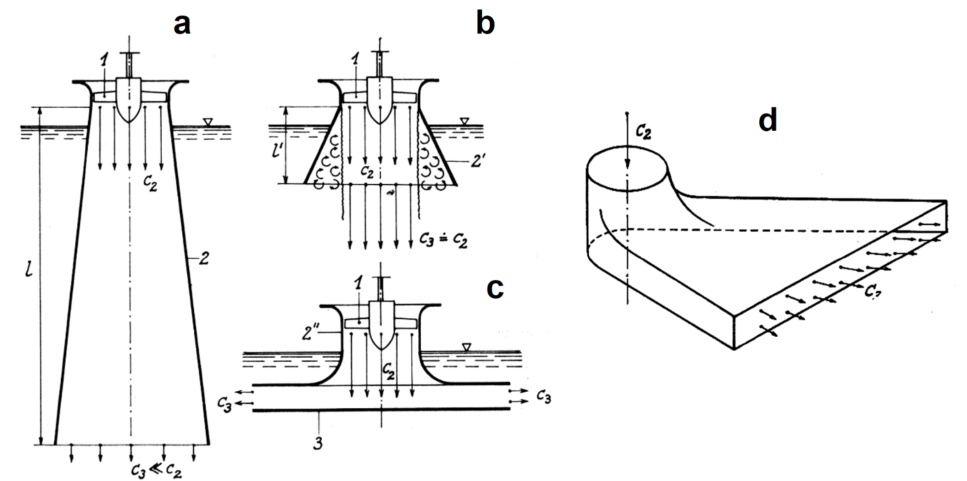
Figure 10. Developmental shapes of the draft tube for the Kaplan turbine. ( a ) Long straight draft tube; ( b ) Short straight draft tube; ( c ) Plate draft tube; ( d ) Elbow draft tube. Source: